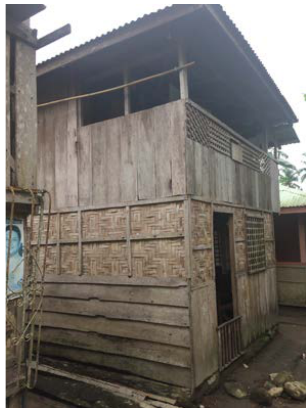
Figure 5. Example house from Plaridel showing timber façade, hipped roof, and concrete slab base.